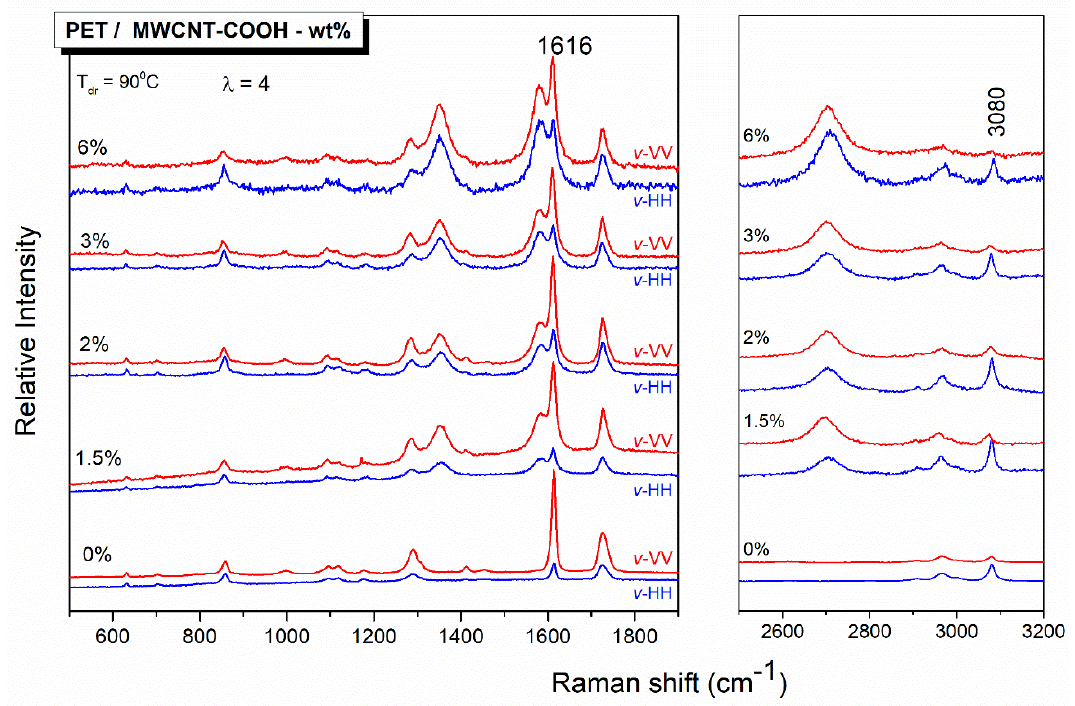
Figure 7. Polarized Raman spectra of PET/MWCNT films, with different carbon nanotube content, drawn to λ = 4 in two different polarization geometries, VV and HH, with respect to the position of the specimen relative to the laboratory-fixed coordinates, v .